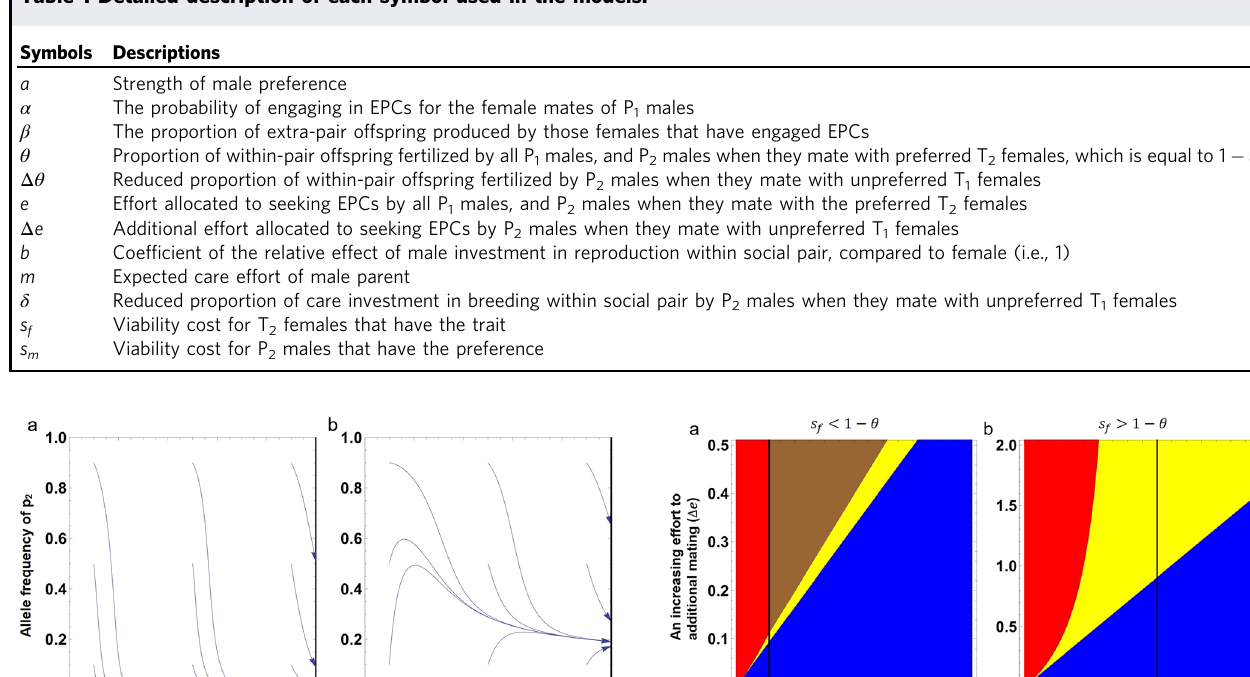
Table 1 Detailed description of each symbol used in the models.